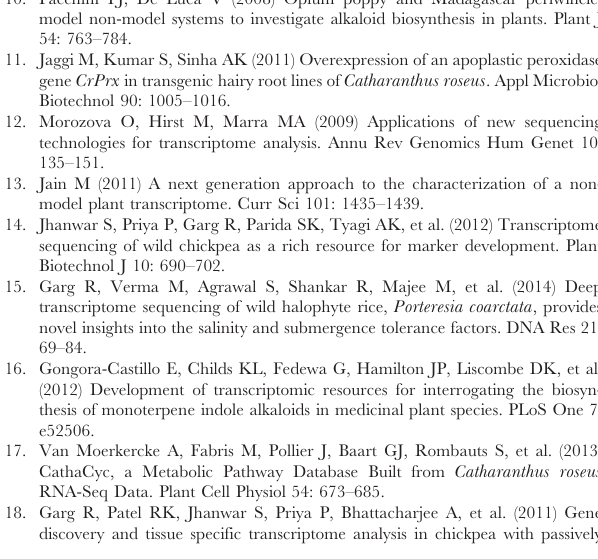
cellular component. (B) COG function classification of C. roseus transcripts. Figure S6 Heat-map showing expression patterns of differentially up-regulated genes in different tissues of C. roseus analyzed in this study. The scale at the bottom represents log 2 fold change. (PDF) Figure S7 Graphical view showing biological process gene ontology term enrichment in up-regulated genes in (A) leaf and (B) root. The GO enrichment was performed using BiNGO. Node size is proportional to the number of genes in each category and shades represent the scale denoting significance level (white- no significant difference). Table S1 Quality control and duplicate read removal statistics of C. roseus libraries. Table S2 De novo assembly statistics by different assemblers at different k-mer length using total high-quality reads (a) Velvet (b) Oases (c) ABySS. Table S3 De novo assembly statistics by different assemblers at different k-mer length using NR high-quality reads (a) Velvet (b) Oases (c) ABySS. Table S4 Primer sequences used for real-time PCR analysis.